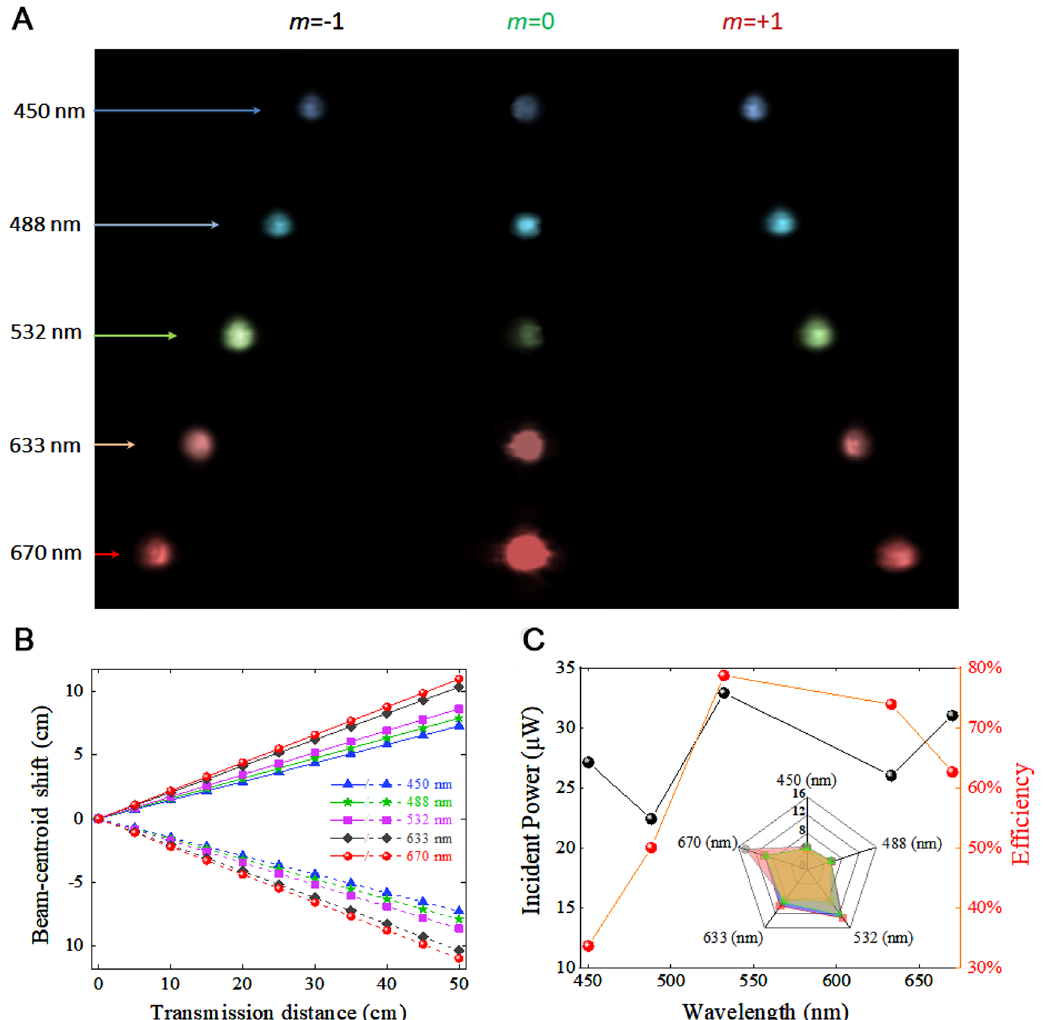
Figure5: Broadbandperformanceofthemetasurface .(A) Experimentallymeasuredfar- fi eldintensitydistributionsinlinearscale,wherefalse colors correspond to their respective wavelengths. (B) Calculated results for the beam-centroid shift versus transmission distance with different illumination wavelength. (C) Measured incident power intensity and operating ef fi ciency under different illumination wavelengths. The inset showsthe transmitted power intensity for each diffraction orders m = 0 (gray points and red area), m = − 1 (red points and blue area) and m = + 1 (green points and yellow area) with different illumination